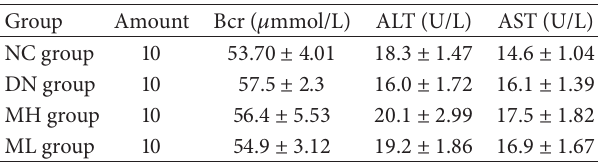
Table 3: Results of Bcr, ALT, and AST. The values of Bcr, ALT, and AST do not change in each group (𝑃 > 0.05)